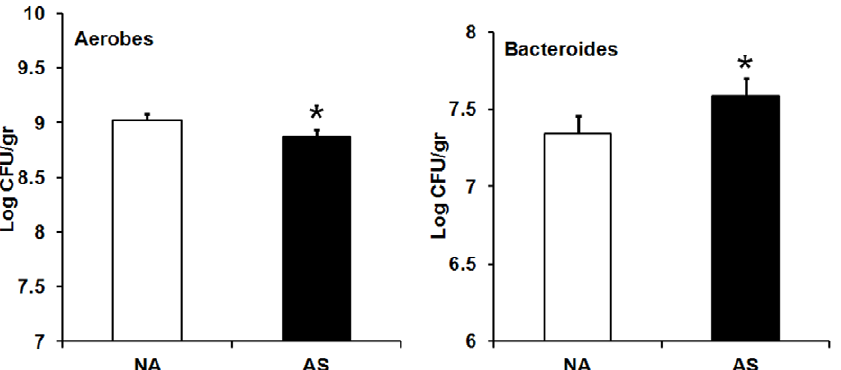
Figure 7. Effect of adult stress on faecal counts of aerobic bacteria and Bacteroides . Effect of exposure to stress in adulthood (week 12) on faecal counts of aerobic bacteria and Bacteroides (Log CFU/gr, least squares means + SE). The hollow bars represent animals exposed to no adult stress (NA): Aerobes NA (n=72), Bacteroides NA (n=67). The filled bars represent animals exposed to adult stress (AS): Aerobes AS (n=75), Bacteroides AS (n=75). An asterisk (*) indicates statistical significant difference ( p #